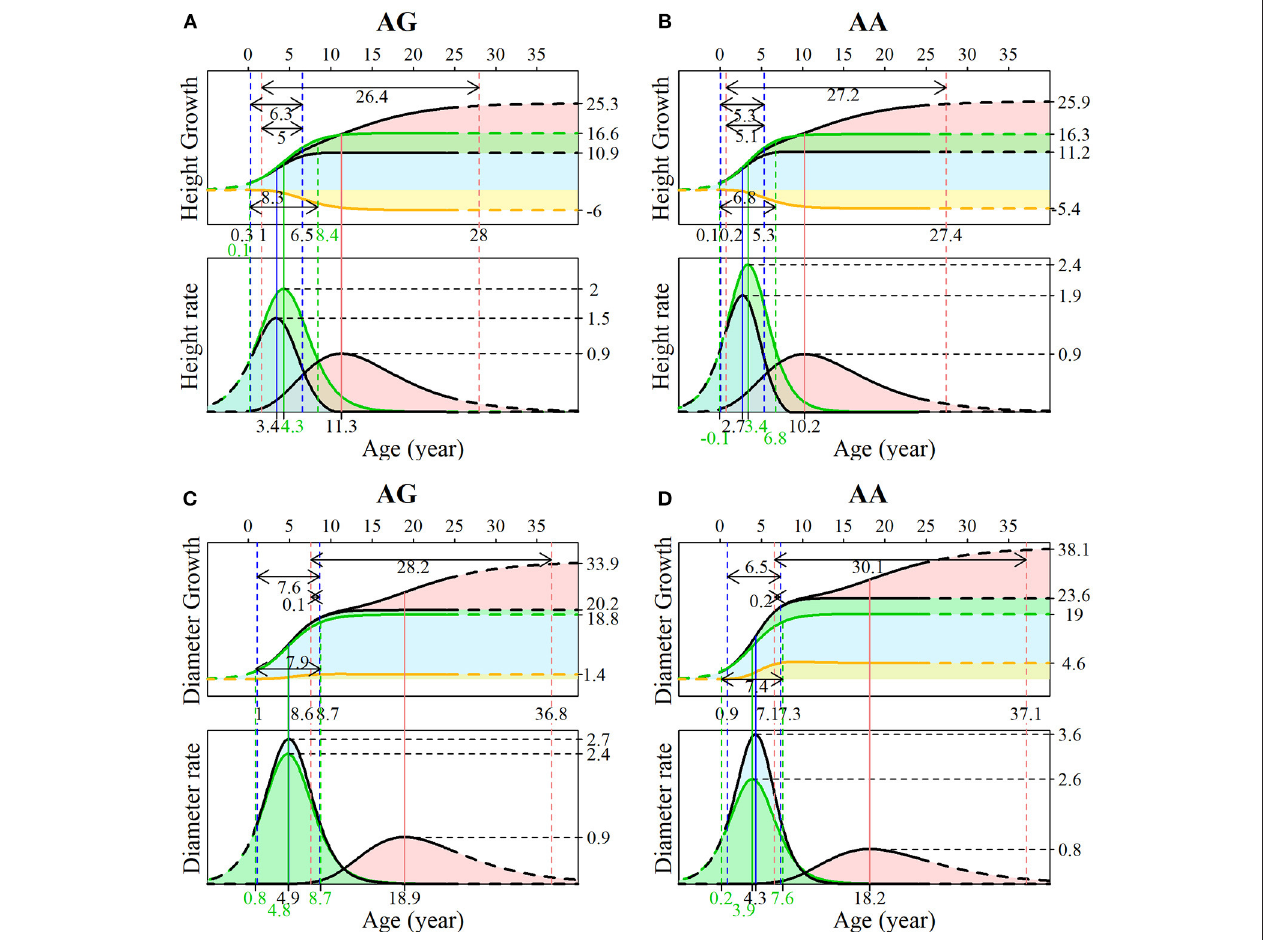
FIGURE 5 | Genotypic growth curves and rate curves of stem (A,B) height and (C,D) diameter. The growth is explained by SNP 137076 with two genotypes, AG and AA. For each image, the upper panel is the growth curve, and the lower panel is the rate curve. The blue area represents the first phase of growth, where green represents the independent growth and yellow represents the interacting growth. The pink areas indicate the second phase of growth.